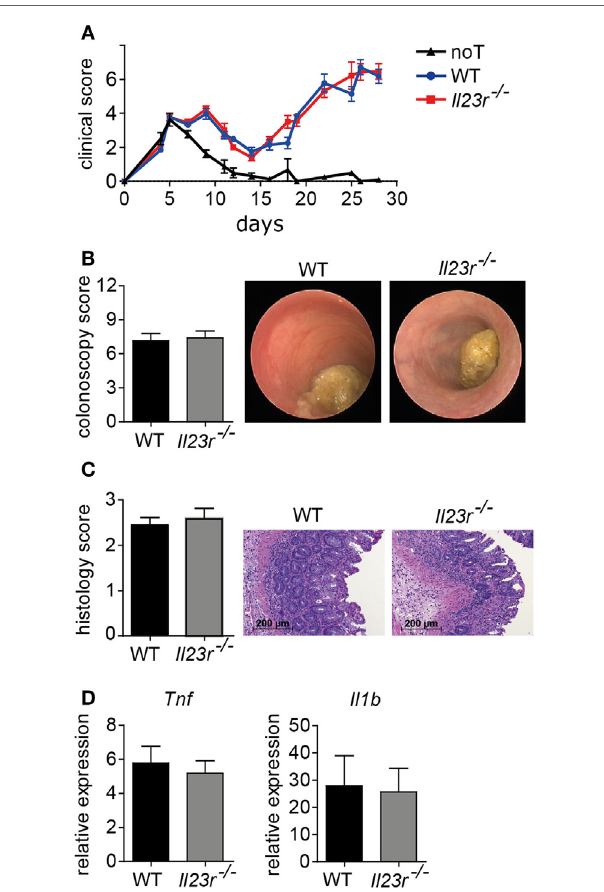
FigUre 1 | Interleukin-23 receptor (IL-23R) expression by donor T cells is not required for acute graft-versus-host disease (GvHD)-associated colitis manifestation. To induce GvHD, BALB/c mice were irradiated (day 0), received intravenously T cell-depleted bone marrow (BM) (day 1) and were subsequently injected with allogeneic splenic CD3 + T cells of C57BL/6 [wild type (WT); n = 14] or Il23r − / − ( n = 15) mice (day 2). As a control, mice received T cell-depleted BM alone (noT; n = 8). (a) Mice were observed three times a week and clinical symptoms of GvHD were scored. Data were analyzed by two-way ANOVA followed by Bonferroni’s multiple comparisons posttest. (B) At day 28, colitis severity was assessed by colonoscopy and representative endoscopic images are shown. Mice were sacrificed between day 28 and day 30. (c) Histopathological scoring of the inflammation present in the distal colon (WT n = 11; Il23r − / − n = 12). One representative hematoxylin and eosin-stained histopathological cross-section of the distal colon per group is shown. Scale bars: 200 µm. (D) Transcript levels of Tnf and Il1b in colonic tissue of WT ( n = 14) or Il23r − / − ( n = 15) T cell receiving mice as described above were analyzed by quantitative real-time PCR. Data are combined from two individual experiments. Data were analyzed by Student’s t -test and are shown as mean ±